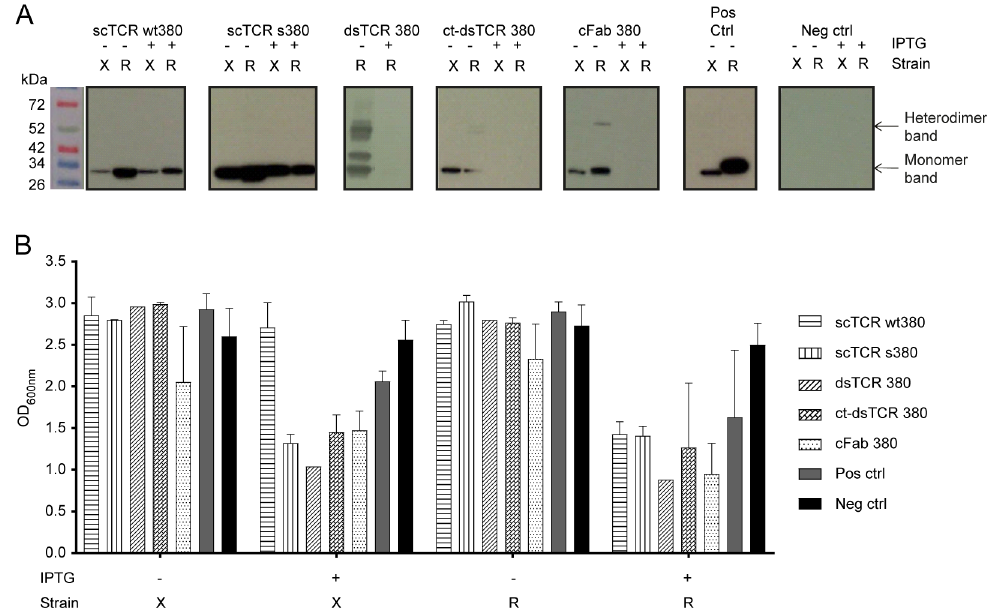
Fig 2. Effect of host strain and induction conditions on periplasmic TCR expression. (A) Representative western blots showing the expression profile of the TCR formats in either E . coli XL1-Blue (X) or RosettaBlue TM (R) where IPTG induction of protein expression either was omitted (-) or included (+). Normalized expression cultures were fractionated before the presence of TCR in the periplasmic fractions was analyzed by western blot detection using an anti-His-HRP antibody (n = 3). (B) The bacterial growth characteristics were monitored by measuring the OD 600nm of E . coli XL1-blue (X) and RosettaBlue TM (R) bacterial cultures after overnight protein expression without (-) or with (+) IPTG induction at 30˚C. n = 3 for all constructs except for controls ( n = 4) and the dsTCR constructs ( n = 1). Standard deviations are indicated where possible. (A, B) Cells expressing scFv anti-phOx were used as positive control and untransformed cells as negative